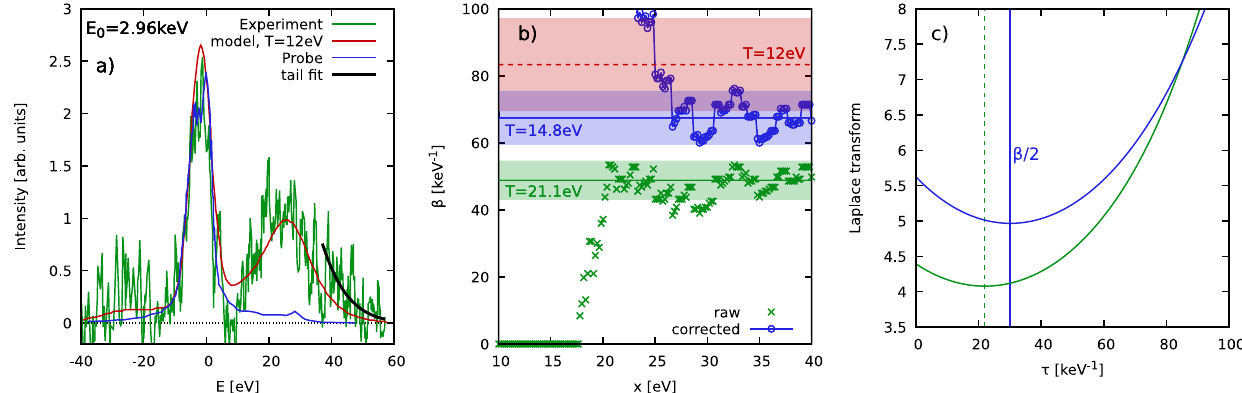
Fig. 2 | Temperature diagnosis of warm dense beryllium. a XRTS measurement by Glenzer et al. 34 (green), theoretical Mermin model (also taken from Ref. 34) giving T model =12±2eV (red), SIF R ( E ) (blue), and averaged tail for E ≥ 40eV (black); b convergence of our model-free temperature diagnosis with respect to theintegrationboundary x of L S ð q , E Þ½ (cid:2) with(blue)andwithout(green)correcting